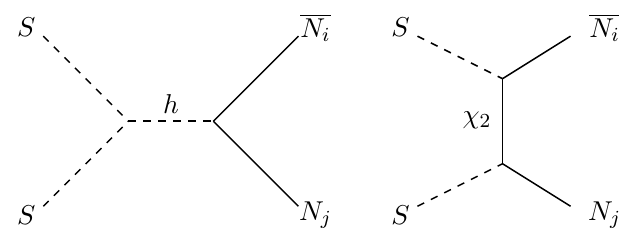
Figure 6 . Diagrams contributing to DM-DM conversion ( i = 1 ; 2) between fermion ( N i ) and scalar DM ( S )